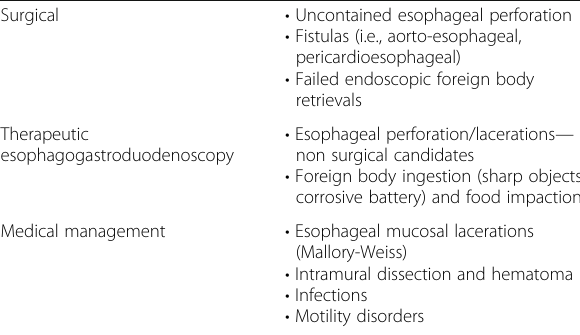
Table 1 Management of acute esophageal pathologies